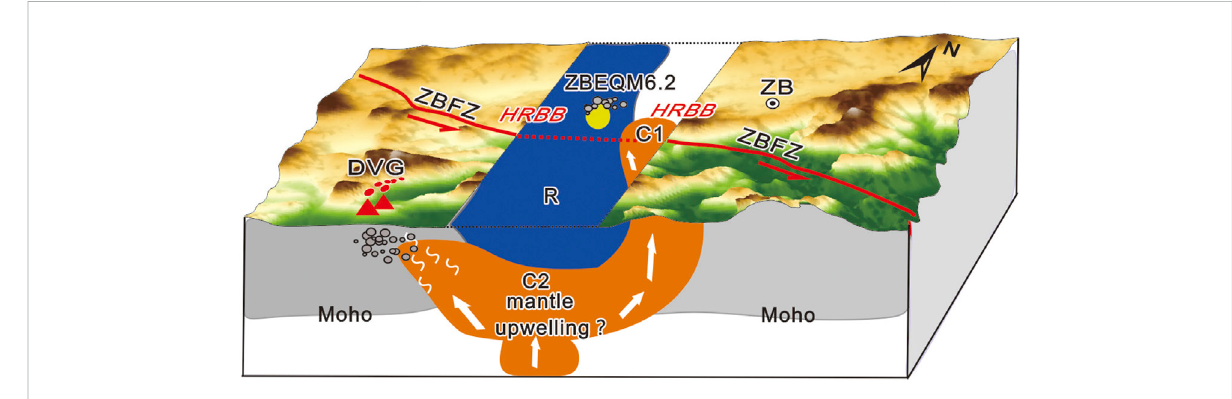
FIGURE 11 Schematic model of the seismogenic environments and formation mechanism for volcanism in the